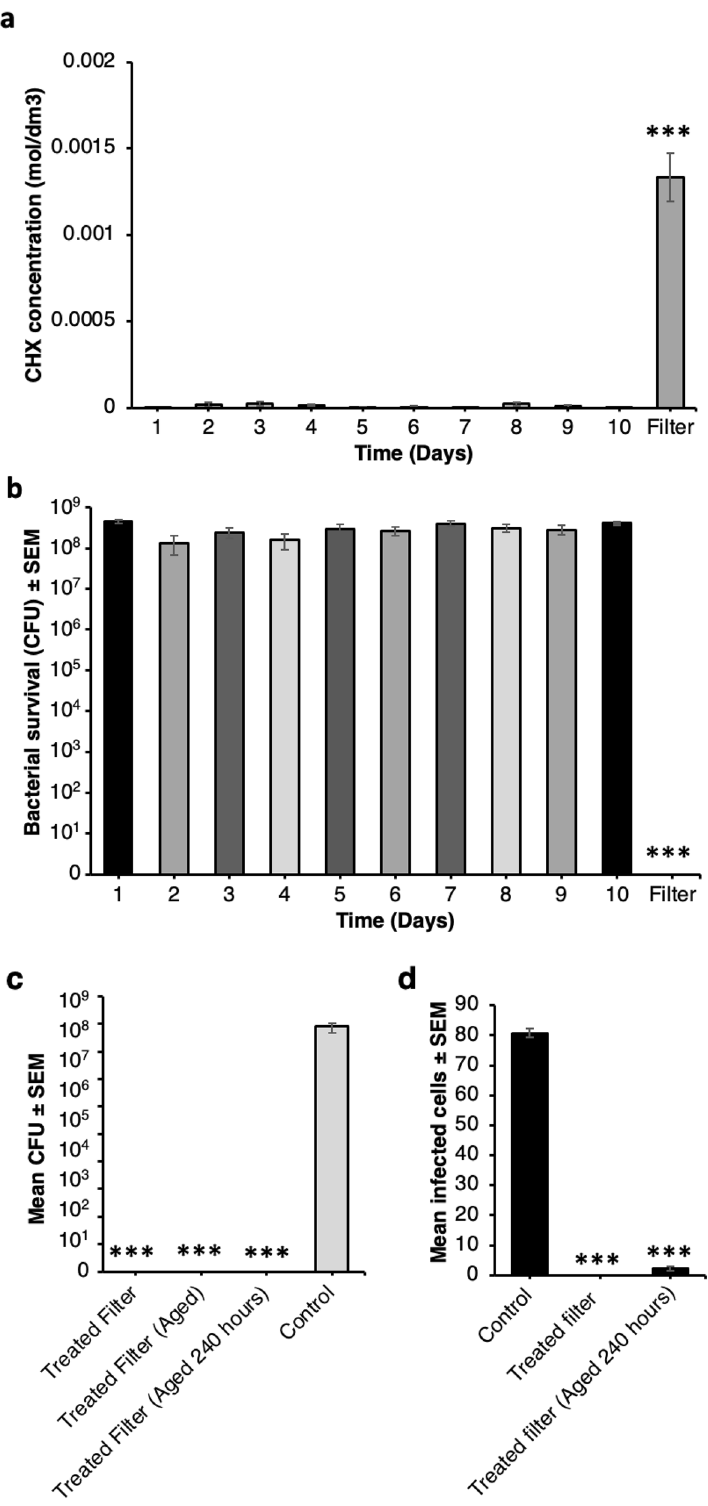
Figure 5. Filter durability. ( a ) Mean concentration of chlorhexidine leached from the filters over time and the concentration of chlorhexidine remaining in the filter at the end of durability testing measured using an absorbance assay. Error bars show standard error of the mean, n = 9, *** denotes statistical significance p < 0.001. ( b ) Mean bacterial survival after incubation in chlorhexidine extract from durability filter test measured in ( a ). Error bars show standard error of the mean, n = 9, *** denotes statistical significance p < 0.001. ( c ) Antimicrobial efficacy of filters before and after durability testing against E. coli . Error bars show standard error of the mean, n = 9, *** denotes statistical significance p < 0.001. ( d ) Antiviral efficacy of filters before and after durability testing against SARS-CoV-2. Error bars show standard error of the mean, n = 9, *** denotes statistical significance p <